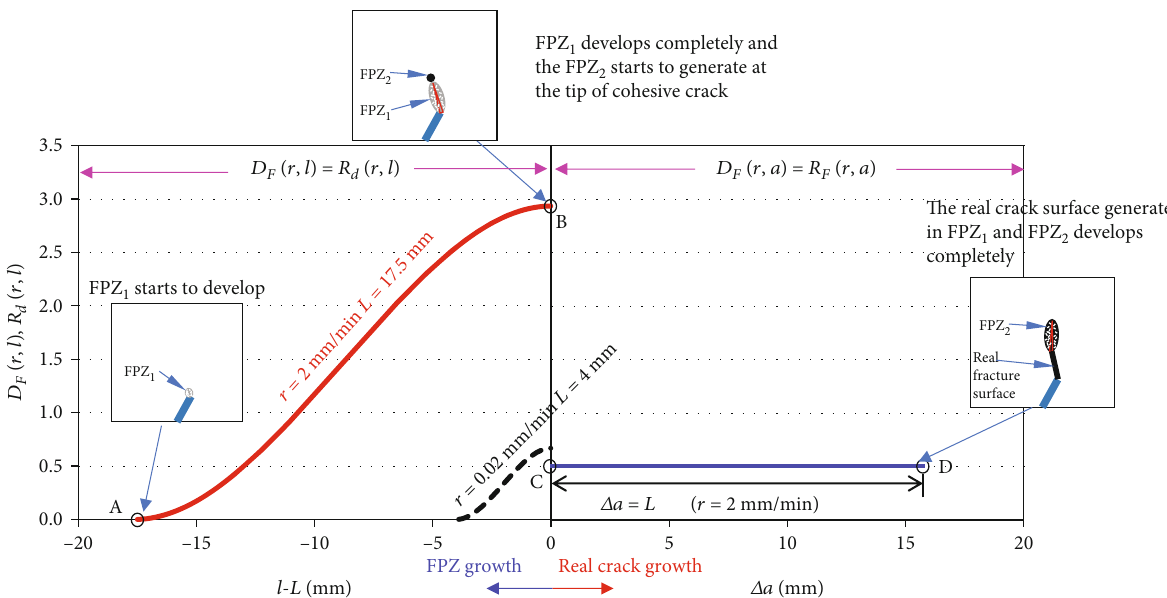
Figure 5: Schematic diagram of fracture resistance and driving force curves of the stable propagation of mixed-mode cracks at di ff erent loading rates.